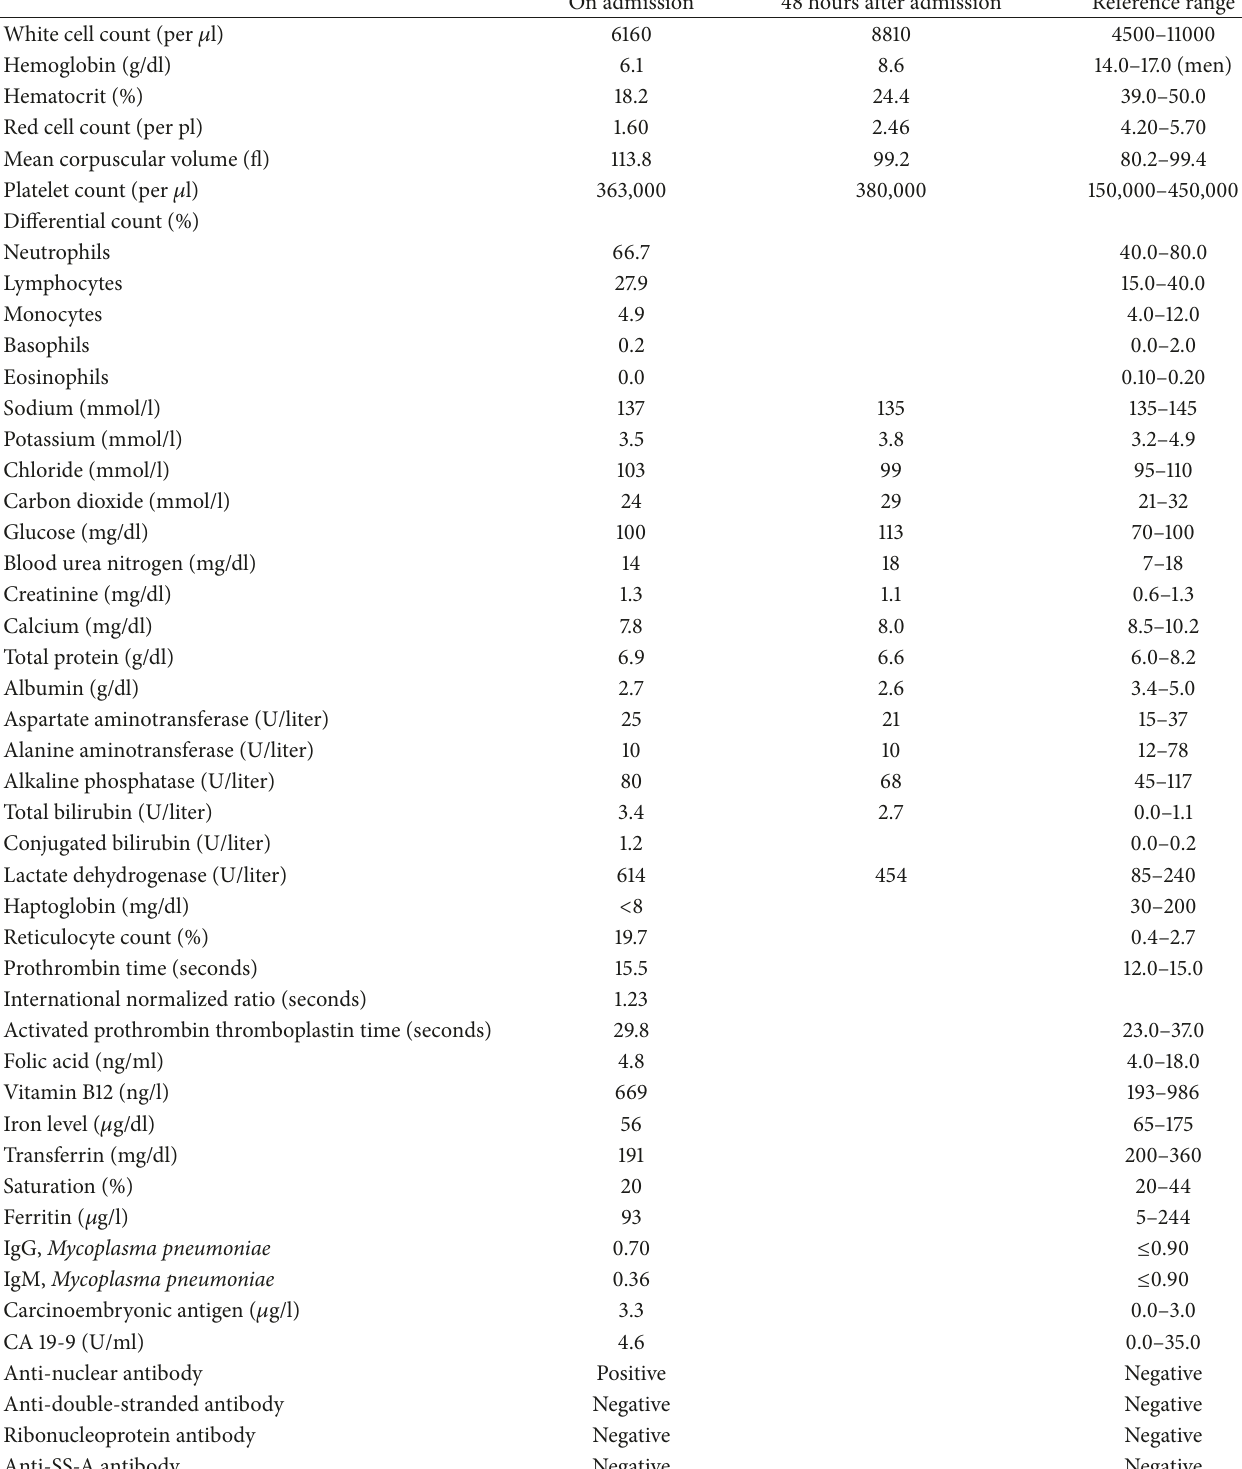
Table 1: Laboratory